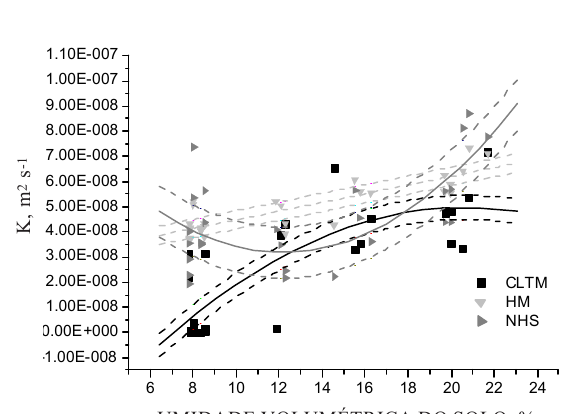
Figura 4. Difusividade térmica na camada de 0–5 cm, segundo os três métodos utilizados (CLTM, HM e NHS).